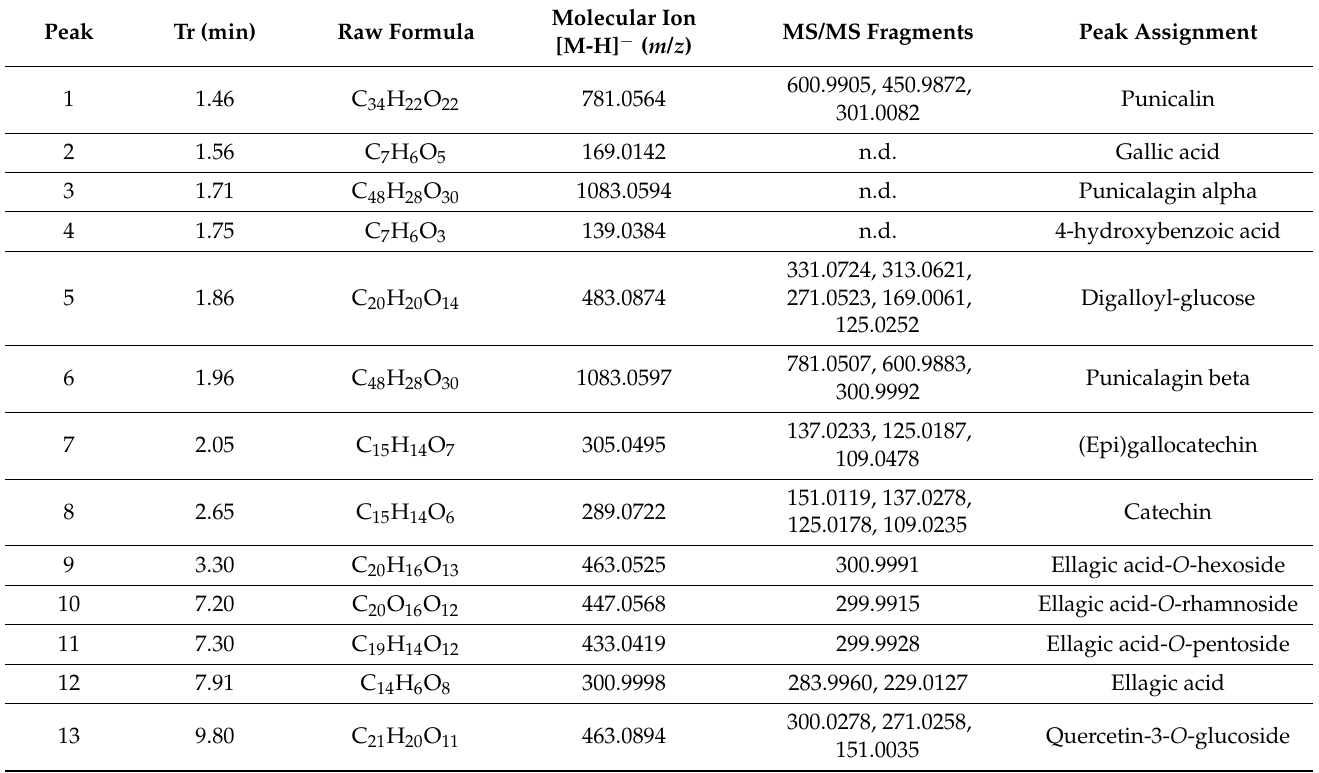
Table 3. Peaks detected in the extracts of fruit peels of P. granatum by HPLC-ESI-Q-ToF analysis (peak numbers are referred to the chromatograms presented in Supplementary Figure S2).